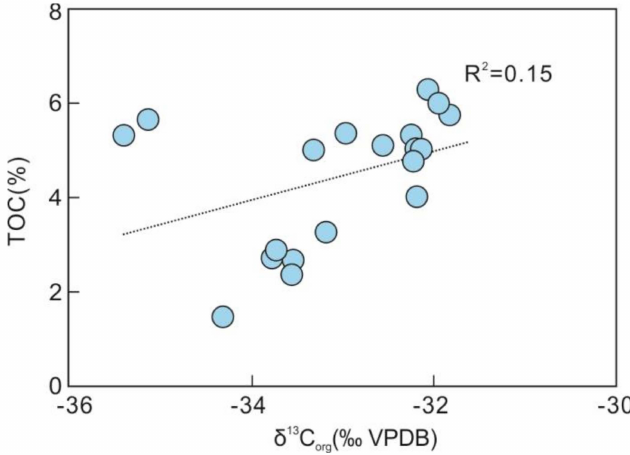
Figure 3. Crossplot of δ 13 Corg and TOC contents for the Meiziwan